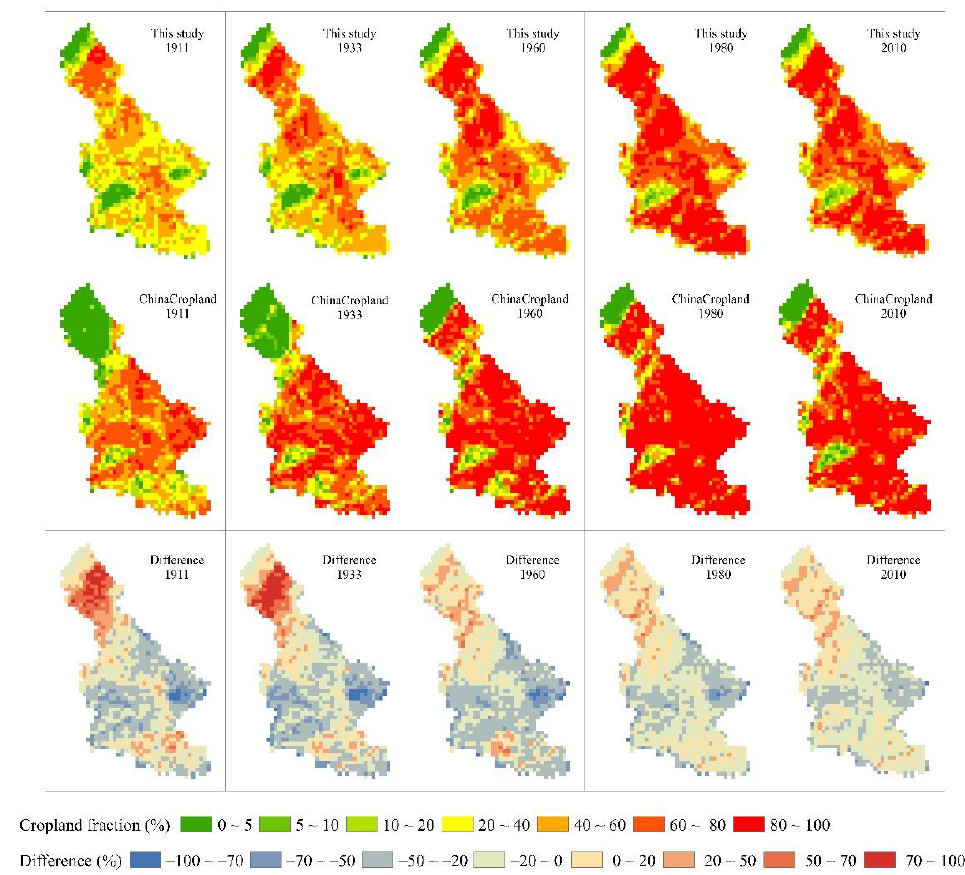
Figure 11. Comparison of the cropland spatial fractions presented by ChinaCropland and this study.